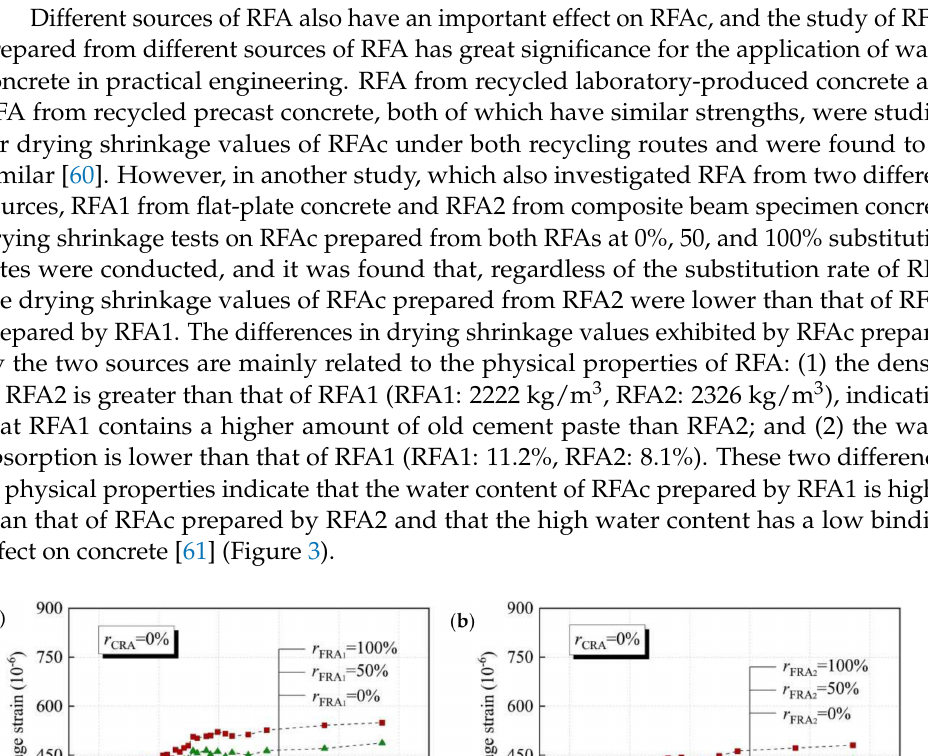
Figure 2. Dry shrinkage of RS (river sand) and RFA concrete [58].